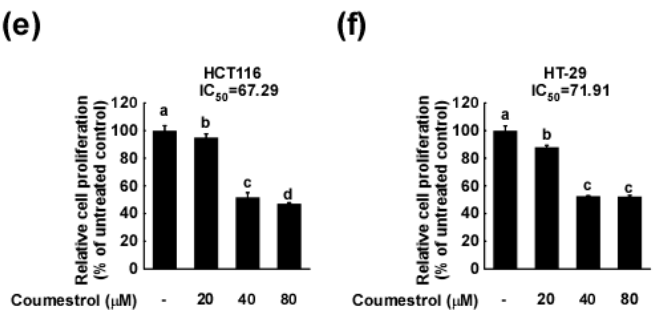
Figure 1. Anti-cancer cell growth effect of coumestrol in several cancer cell lines, ( a ) SK-Mel5; ( b ) SK-Mel 28; ( c ) SK-Mel 2; ( d ) A549; ( e ) HCT116; and ( f ) HT-29. 2 × 10 3 cells were seeded to each well of a 96-well plate, before 20, 40 or 80 µ M of coumestrol was added as treatment. Cell growth was measured using Cell Titer96 Aqueous One Solution (Promega) as described in the Materials and Methods. Each data is the mean ± standard deviation of three replicates. Different letters indicate the significant differences at p < 0.05 by Turkey multiple range tests.